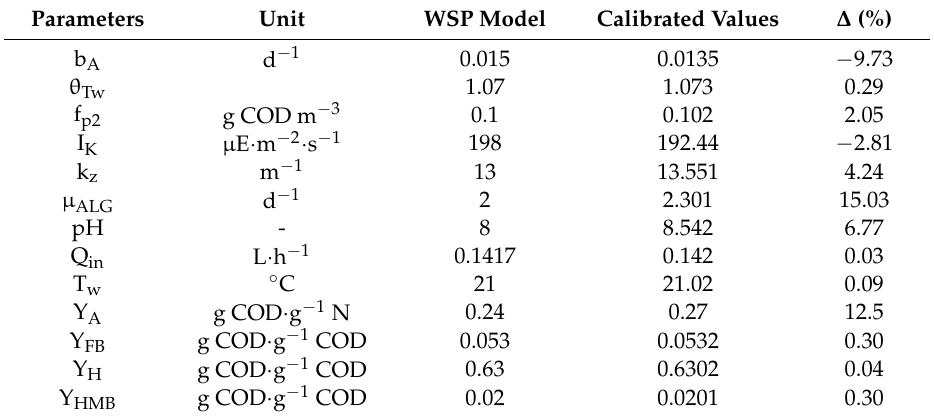
Table 4. Original and calibrated values of the selected parameters in the WSP model.